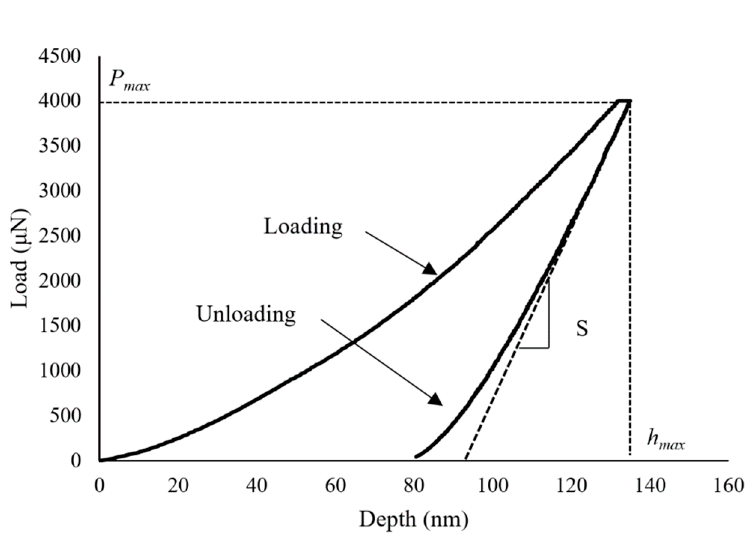
Figure 3. Load-depth curve for the nano-indentation test for the steel particles.